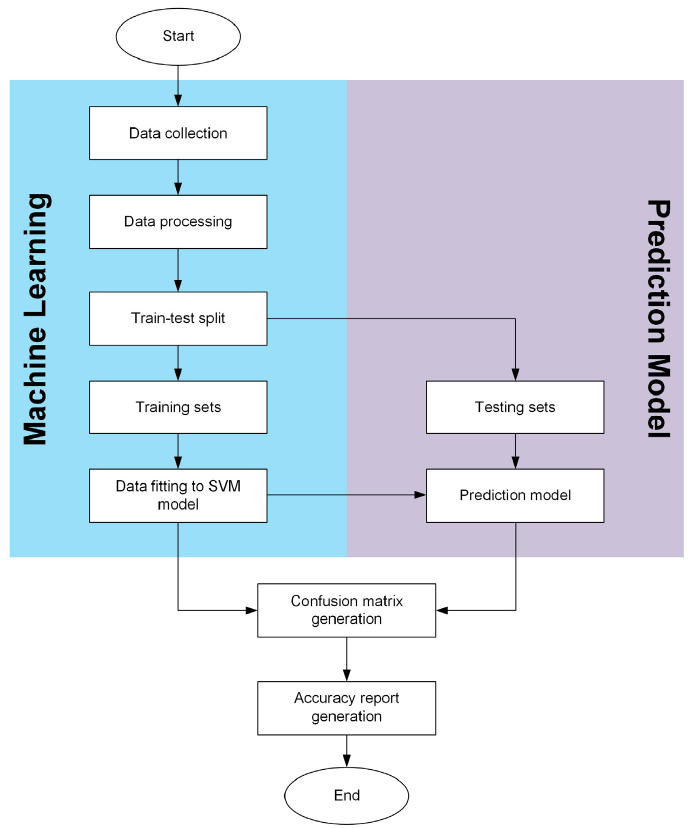
Figure 6. Flowchart of the SVM algorithm.